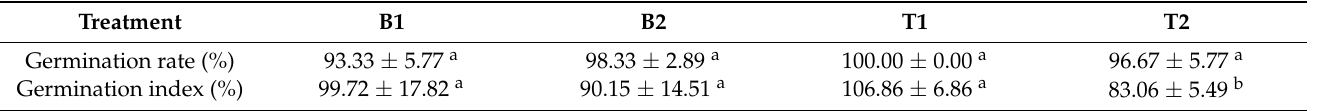
Table 4. Germination rate and germination index of rape